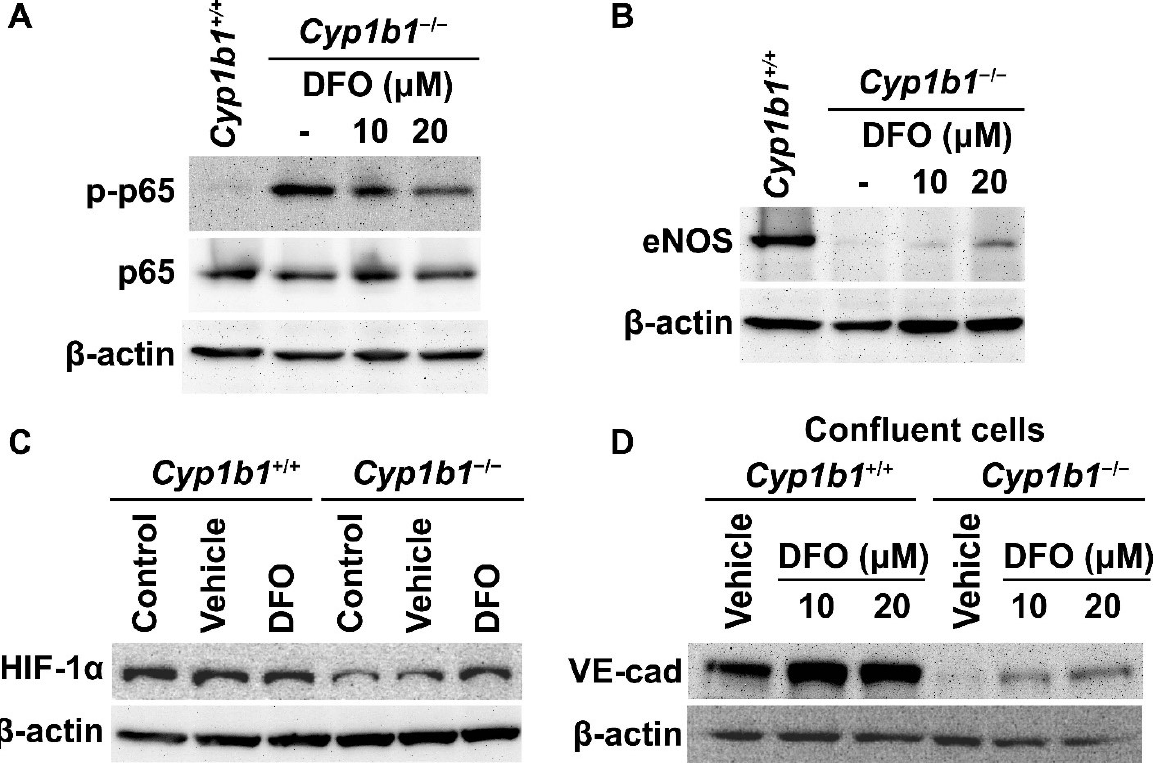
Figure 4. Iron chelation partially reversed molecular changes associated with the lack of CYP1B1 expression in retinal ECs. Cell lysates from Cyp1b1 −/− retinal ECs incubated with 10 or 20 µM of DFO for 24 h and Cyp1b1 +/+ retinal ECs without DFO incubation were prepared. Phosphorylated nuclear factor κB p65 (p-p65), p65 ( A ) and endothelial nitric oxide synthase (eNOS) ( B ) levels were determined by Western blot analysis. ( C ) Lysates from Cyp1b1 +/+ and Cyp1b1 − / − retinal ECs untreated, incubated with vehicle or 50 µ M DFO for 24 h were prepared for Western blot analysis. HIF-1 α protein levels were accessed by Western blot analysis. ( D ) Cell lysates prepared from 90% confluent Cyp1b1 +/+ and Cyp1b1 − / − retinal ECs incubated with vehicle, 10 or 20 µ M DFO for 48 h, were prepared for Western blot analysis. The VE-cadherin (VE-cad) protein levels were determined. The β -actin levels were determined to control for